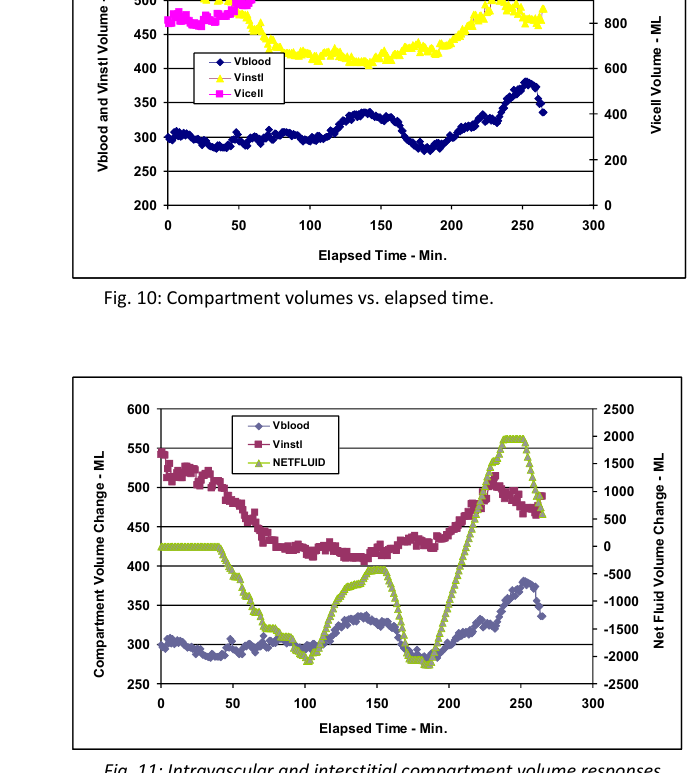
Fig. 11: Intravascular and interstitial compartment volume responses to infusion.